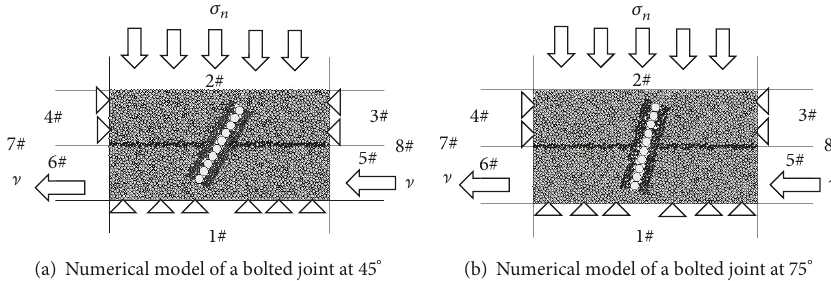
Figure 6: Numerical direct shear test model of the bolted joint.